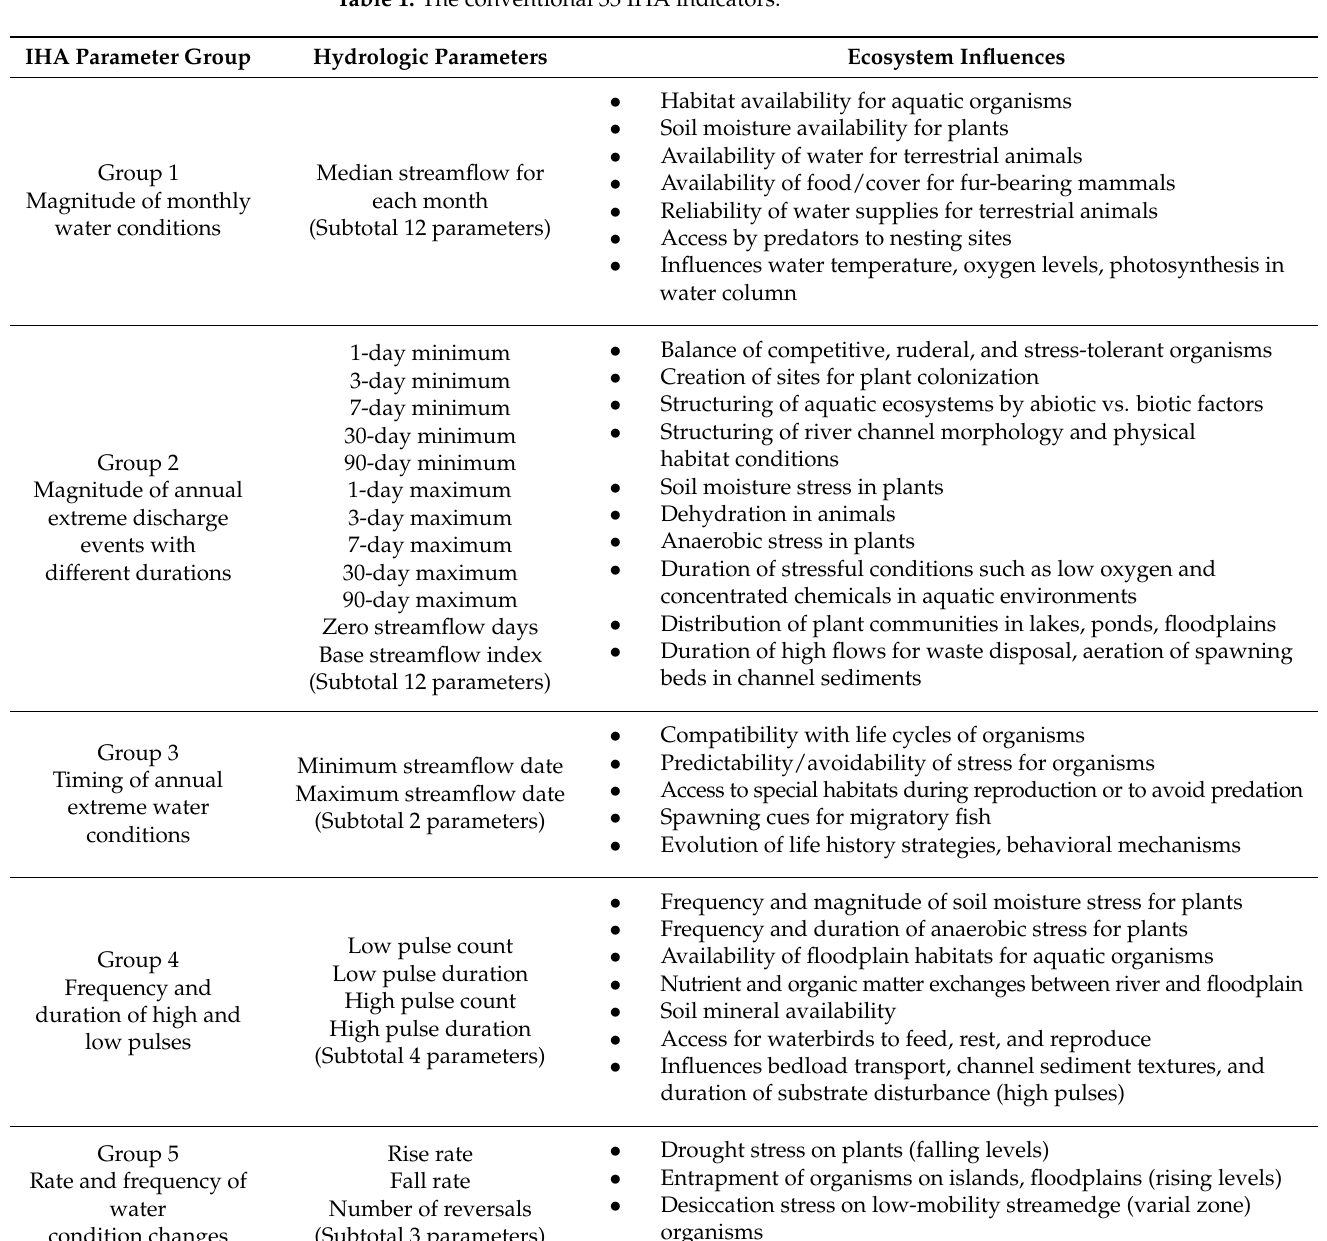
Table 1. The conventional 33 IHA